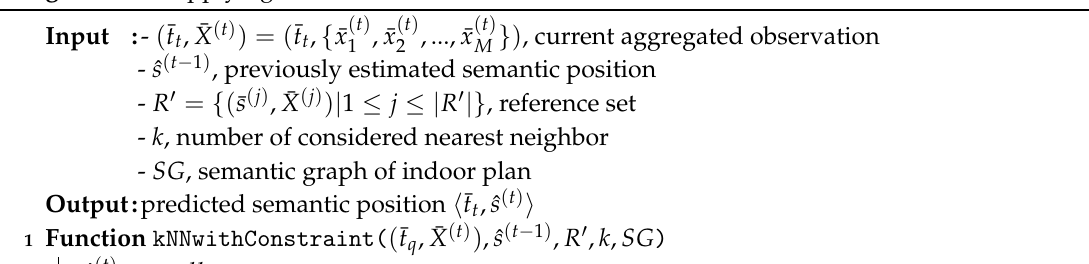
Algorithm 3: Applying a constraint to